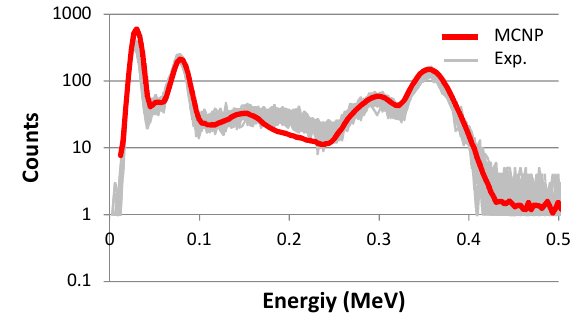
Fig.5. Comparison between 30 experimental and one simulated pulse height distributions from a Ba-133 source for 2s acquisition time.